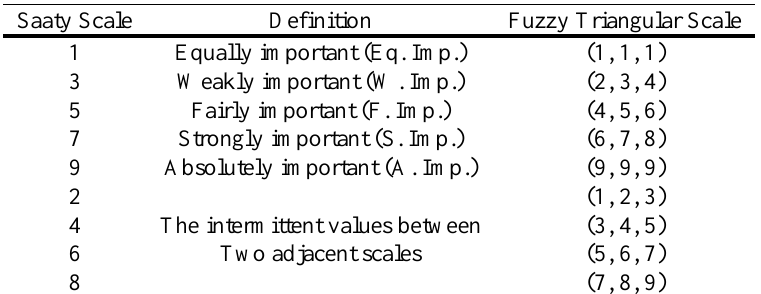
Table 1. Linguistic terms and the corresponding triangular fuzzy